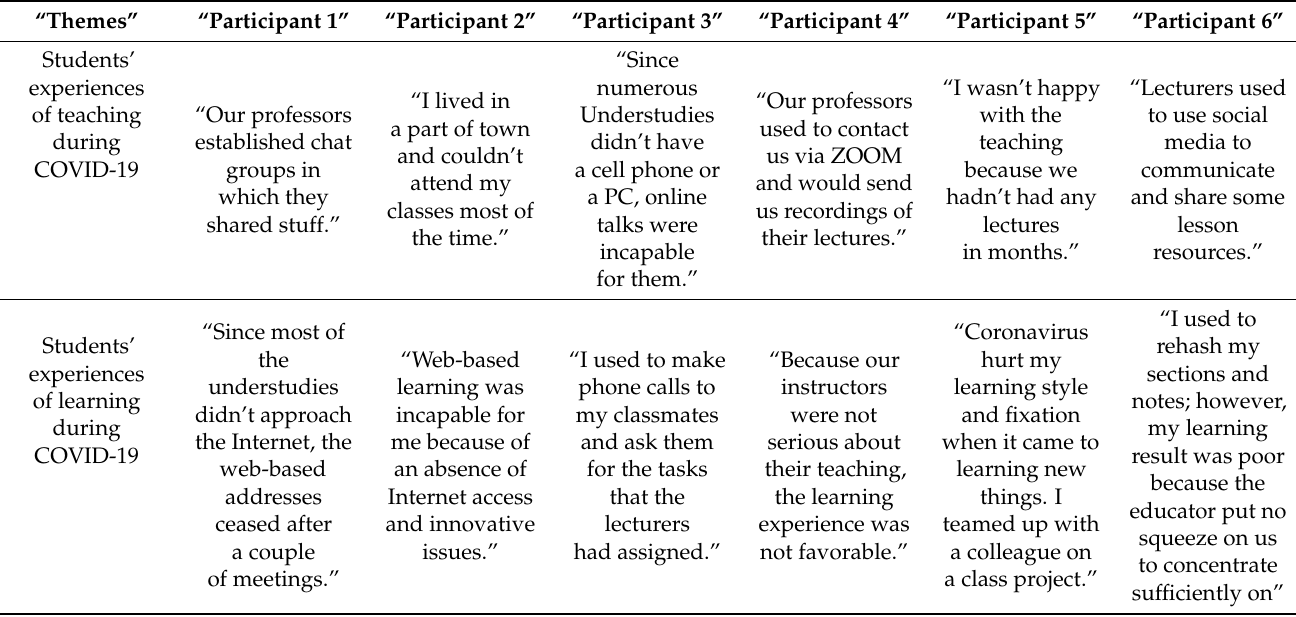
Table 12. Overview of qualitative data source based on interview regarding